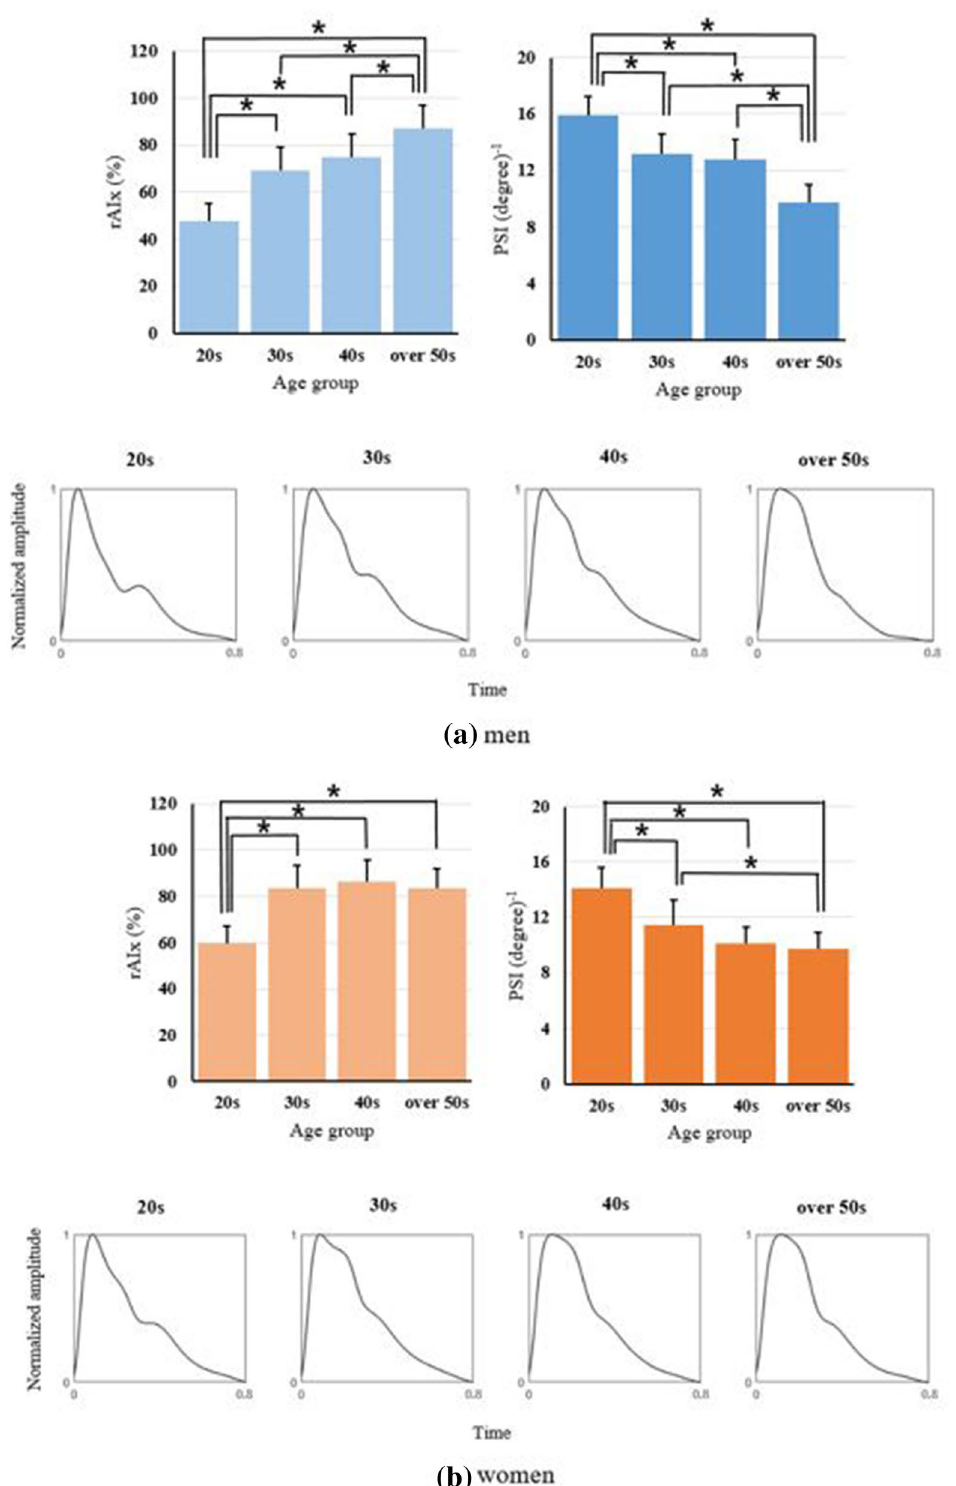
Figure 1. Age-related changes in the radial augmentation index (rAIx) and pulse sharpness index (PSI) according to ( a ) men and ( b ) women. The first row indicates the results of the one-way ANOVA in each age group, and the second row indicates the morphologies of ensemble average pulse waveforms in each age group. *P <